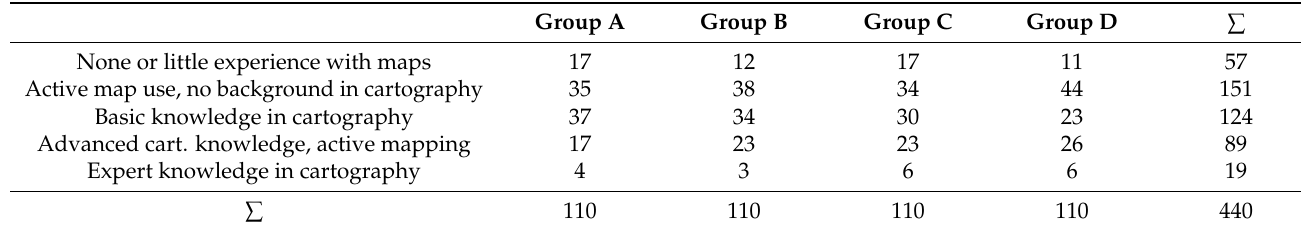
Table 1. Cartographic competence—absolute